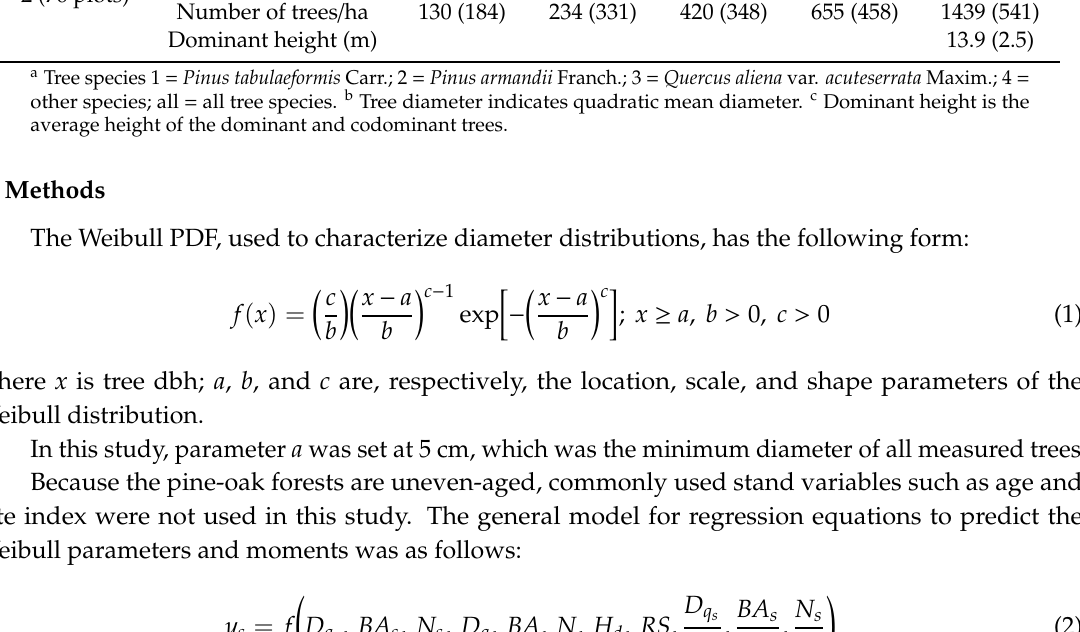
a Tree species 1 = Pinus tabulaeformis Carr.; 2 = Pinus armandii Franch.; 3 = Quercus aliena var. acuteserrata Maxim.; 4 = other species; all = all tree species. b Tree diameter indicates quadratic mean diameter. c Dominant height is the average height of the dominant and codominant